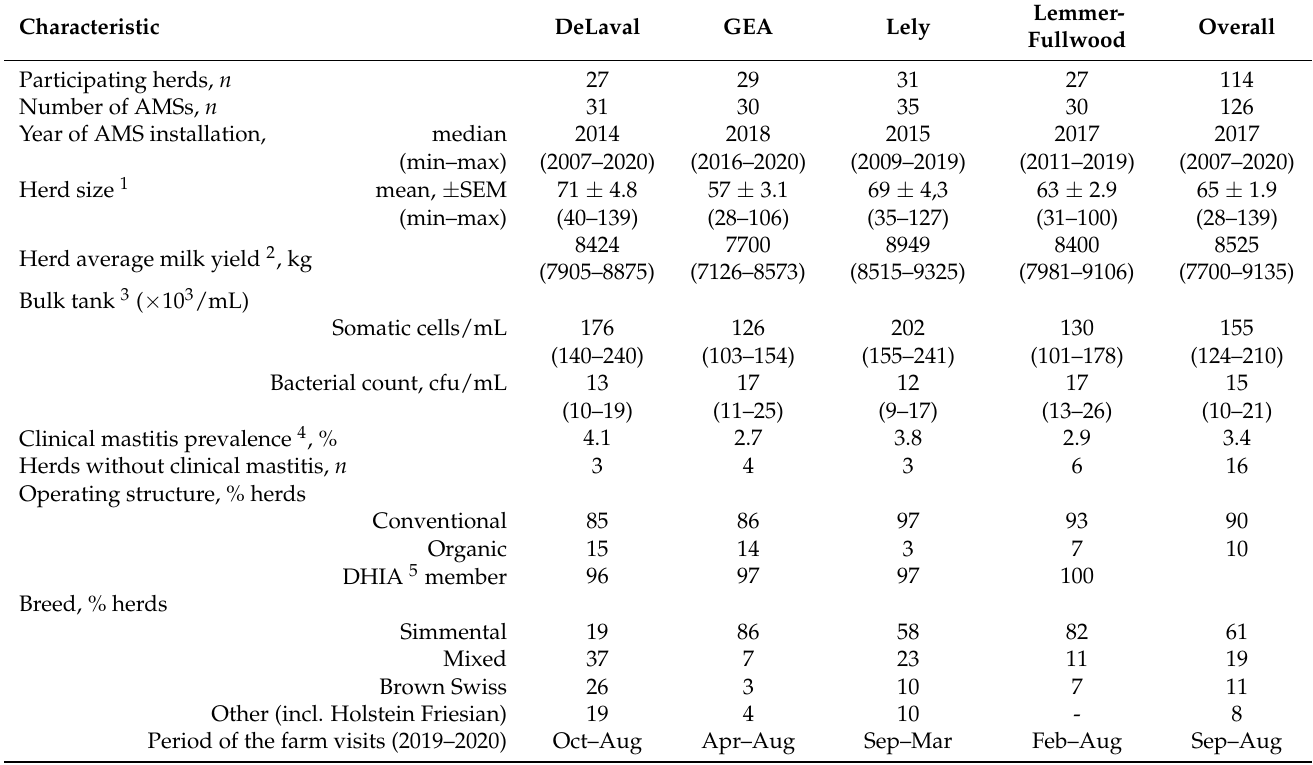
Table 4. Overview of the characteristics of participating herds summarized per manufacturer. Farm visits between September 2019 and August 2020 for a study on AMS system accuracy in Bavarian dairy herds. Unless otherwise stated, the median (25th–75th percentile) is